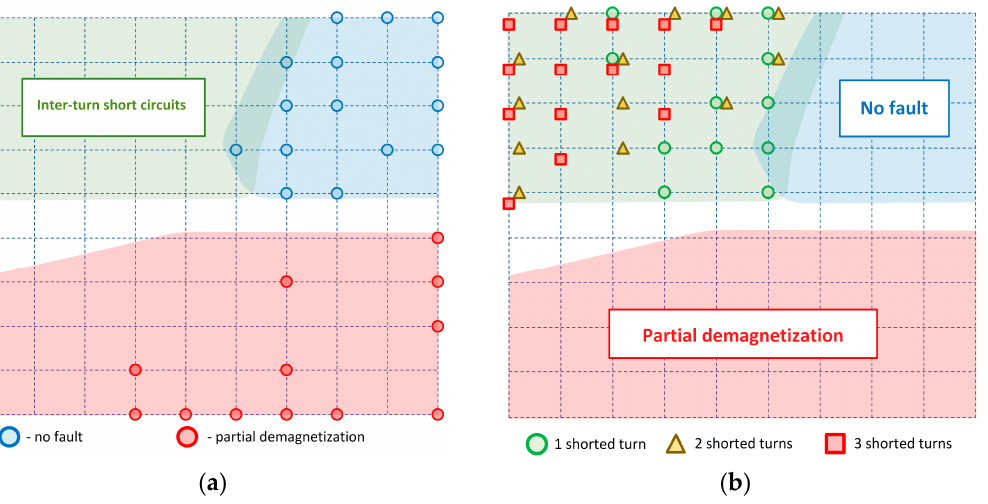
Figure 7. Experimental verification of the SOM-based fault detector of the PMSM motor: ( a ) partial demagnetization of the PMSM– SOM response for testing dataset; ( b ) assessment of stator damage degree — SOM response for testing dataset: Nsh — number of shorted turns.